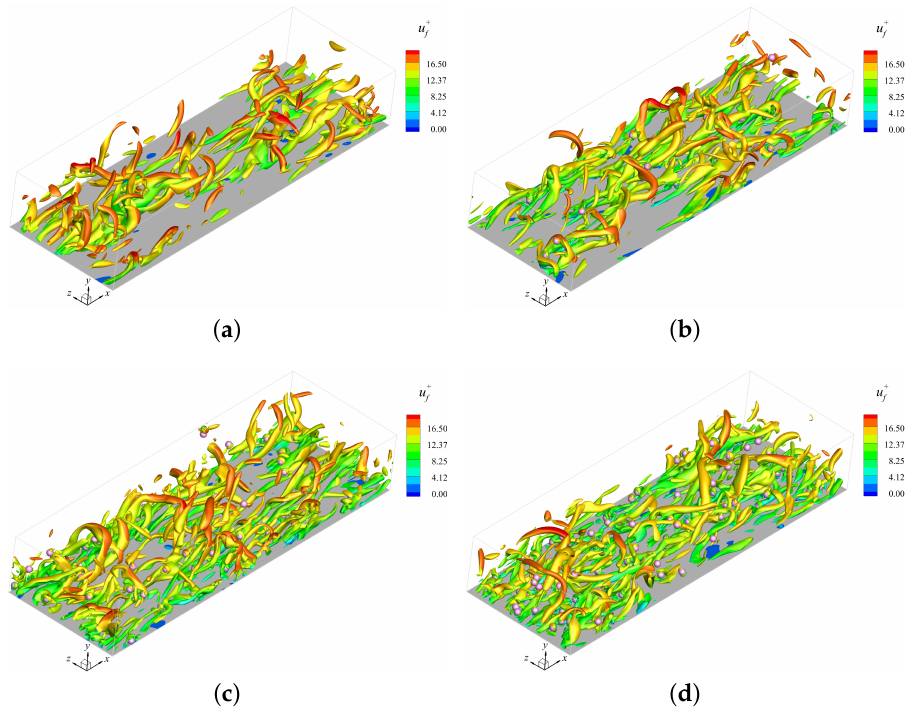
Figure 5. Vortical structures visualized by the Q -criterion at Q / ( u τ 4 / ν 2 ) = 0.01 and colored by the fluid streamwise velocity: ( a ) Single phase, ( b ) φ = 0.11%, ( c ) φ = 0.22%, and ( d ) φ =